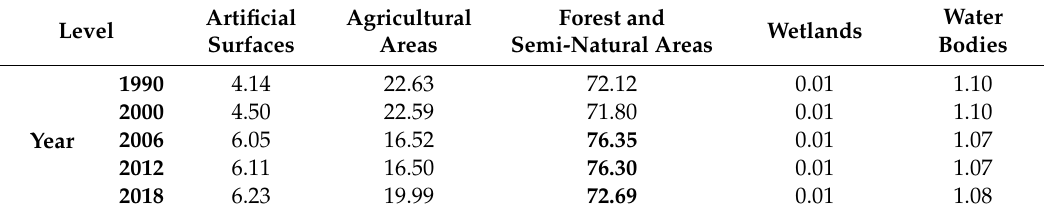
The highest values found are in